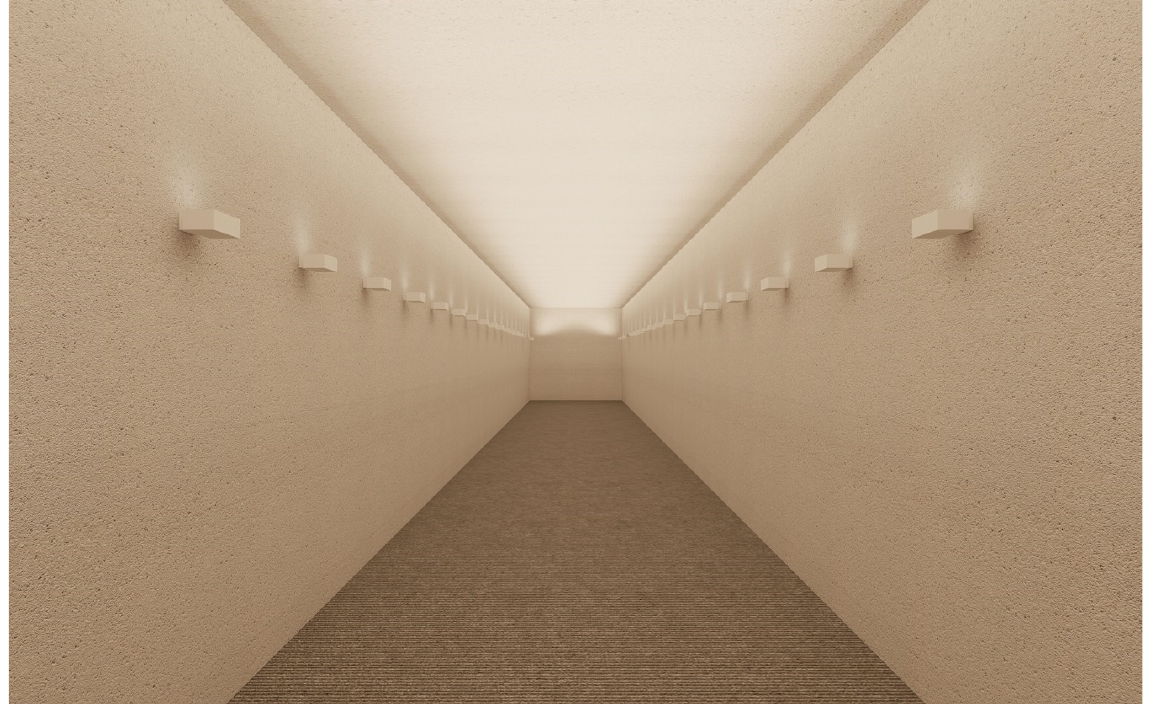
Figure 13. Computer simulation of corridor lighting for variant 10.